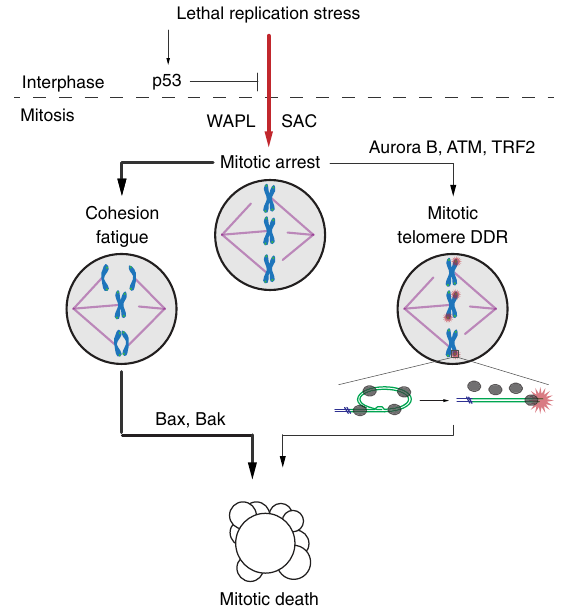
Fig. 8 Model of replication stress-induced mitotic death. In p53-competent cells replication stress prevents mitotic entry, while lethal replication stress induces SAC-dependent mitotic arrest in cells lacking p53 function.